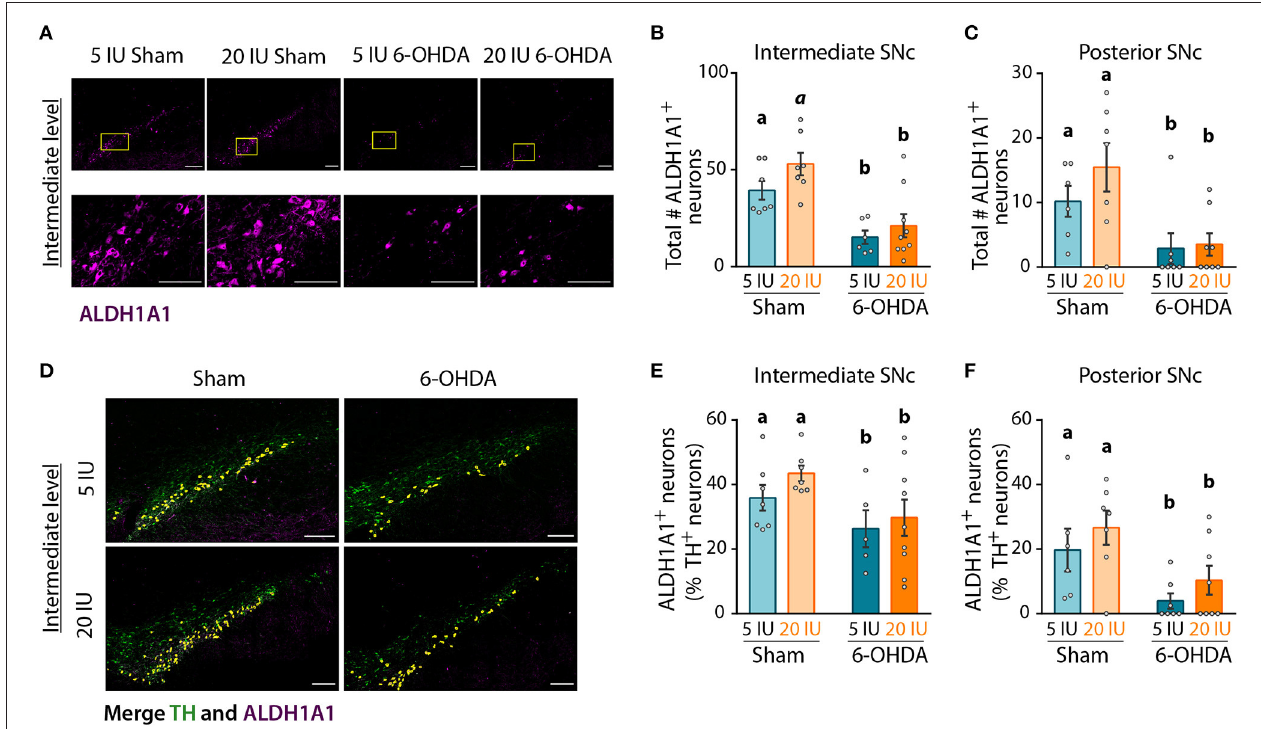
FIGURE 7 | Impact of 6-OHDA lesion and dietary vitamin A on ALDH1A1 + DA neurons. (A) Representative images for the 4 experimental groups of intermediate SNc (lesioned side) immunostained for aldehyde dehydrogenase A subtype a1 (ALDH1A1) (magenta). Top images correspond to a mosaic of multiple images taken individually at 40X, scale bar: 200 µ m. Bottom images correspond to a zoom from mosaic images (yellow squares in top images), scale bar: 100 µ m. (B,C) Quantification of the number (#) of ALDH1A1 + neurons in intermediate (B) and posterior (C) SNc. (D) Representative images for the 4 experimental groups of intermediate SNc (lesioned side) immunostained for tyrosine hydroxylase (TH) (green) and ALDH1A1 (magenta). Co-staining is highlighted in yellow. Scale bar: 200 µ m. (E,F) Quantification of the number (#) of ALDH1A1 + and TH + neurons expressed in percent (%) of TH + neurons in intermediate (E) and posterior (F) SNc. Results are expressed as means ± SEM with individual data points. a, b: values significantly different ( p < 0.005); a indicate a trend for statistical significance ( p = 0.09). Details of the statistical analysis are summarized in Table 3